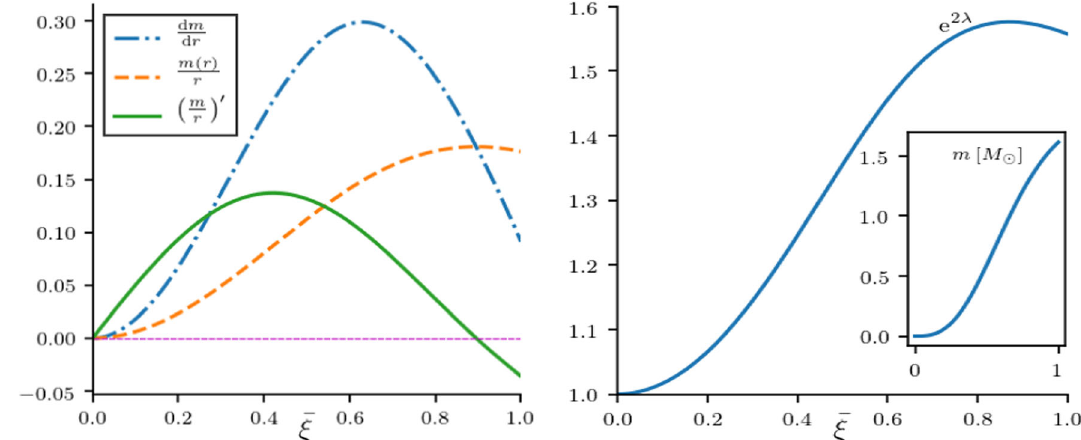
Fig. 1 Theleftplotdisplays m (cid:4) ≡ ϒ( n + 1 ) ˙ η ; m / r ≡ ϒ( n + 1 )η/ξ and ( m / r ) (cid:4) ≡ ϒ( n + 1 )( ˙ η/ξ − η/ξ 2 ) , for models with n = 1 . 5, σ = 0 . 12, α = − 0 . 01, (cid:18) = 0 . 05 and C = 0 . 0625. The right plot exhibits the met- ric potential e 2 λ ≡ 1 − 2 ϒ( n + 1 )η/ξ and the mass function in an inset